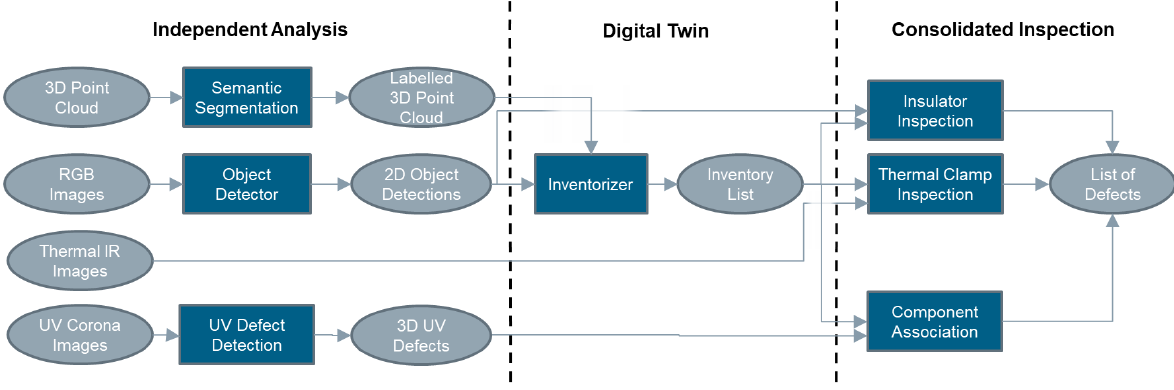
Figure 5. Overview information flow for the analysis steps.